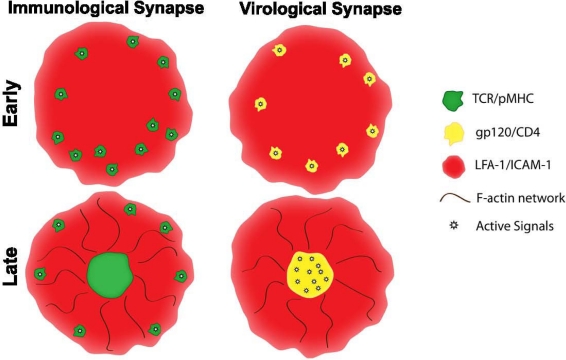
Diagrammatic illustrations of IS and VS at the early and later stage of the synapse assembly as observed in the planar bilayer system. The IS formation is initiated by TCR MCs that are associated with active signaling molecules such as Lck, ZAP70, LAT and SLP76 (top left). Within 2–3 minutes, TCR MCs converge to form the IS cSMAC, and active signaling is terminated. Active signaling, however, is sustained in the IS within the TCR MCs that are continually being formed at the periphery (bottom left). The VS is assembled from gp120 MCs that are also associated with active Lck (top right). However, in the VS, active signaling persists even after gp120 MCs converge to the cSMAC (bottom right). In both IS and VS, LFA-1-ICAM-1 interaction segregates to the pSMAC that surrounds the cSMAC, forming the hallmark bull’s eye structure. The actin cytoskeleton also rearranges to form an F-actin-depleted cSMAC in both synapses.